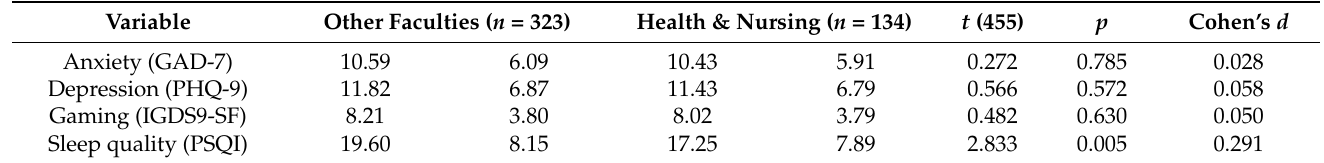
Table 4. Student’s t -test for study track